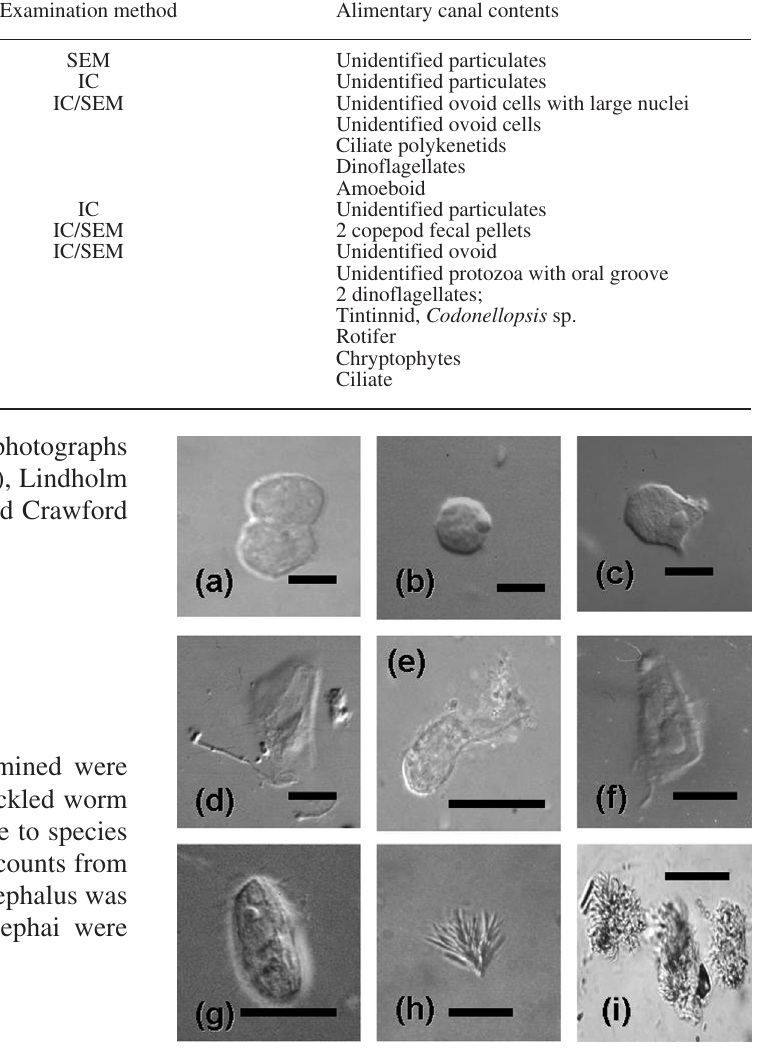
F ig. 1. – Interference contrast photomicrographs of tentatively identi- fied organisms or cell parts from the alimentary canal of a worm